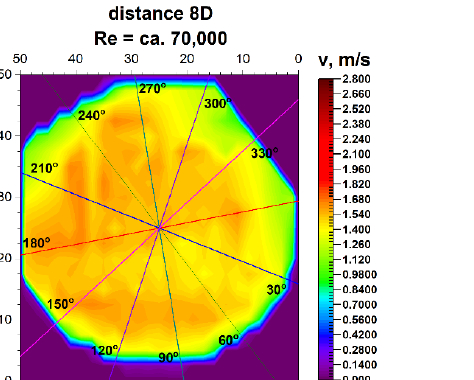
Figure 18. Comparison of projections on the velocity blocks the distances 10D from the disturbance with marked cross- sections for Re ≅ 70,000 and 100,000. Figures 19 and 20 illustrate the comparison of velocity profiles obtained by laser Dop- pler anemometry at distances of 8D and 10Dalong the path of the ultrasonic wave. That allows to clearly illustrate the nature of the obtained results. Figure 19. Comparison of velocity profiles at a distance 8D from the disturbance with marked cross-sections for Re ≅ 70,000 and 100,000-The LDA measurement taken in the ultrasound wave path.